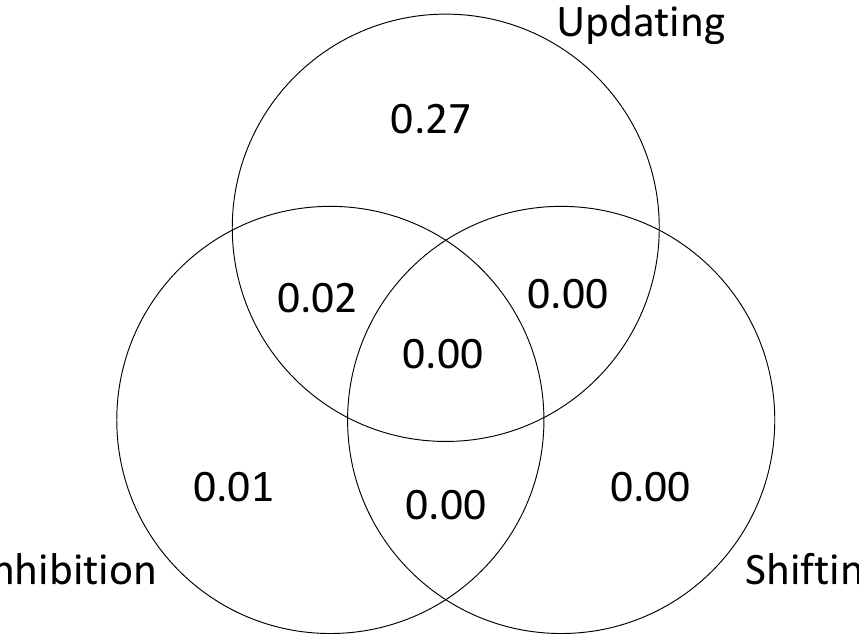
Figure 7. Reanalysis of Friedman et al. (2011). Inh = inhibition; Upd = updating; Shf = shifting; WIQ = WAIS IQ.